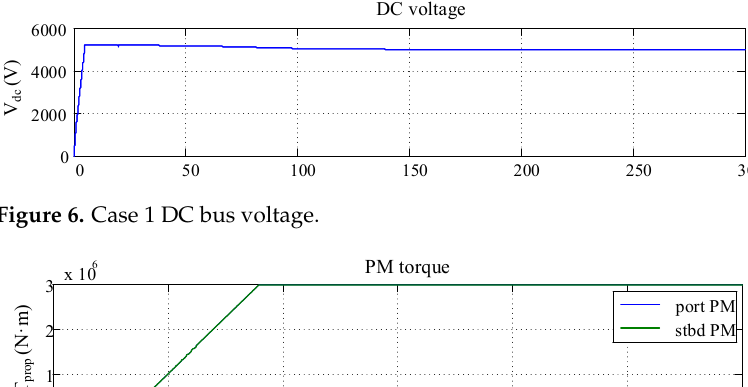
Figure 5. Case 1 generator current and power.